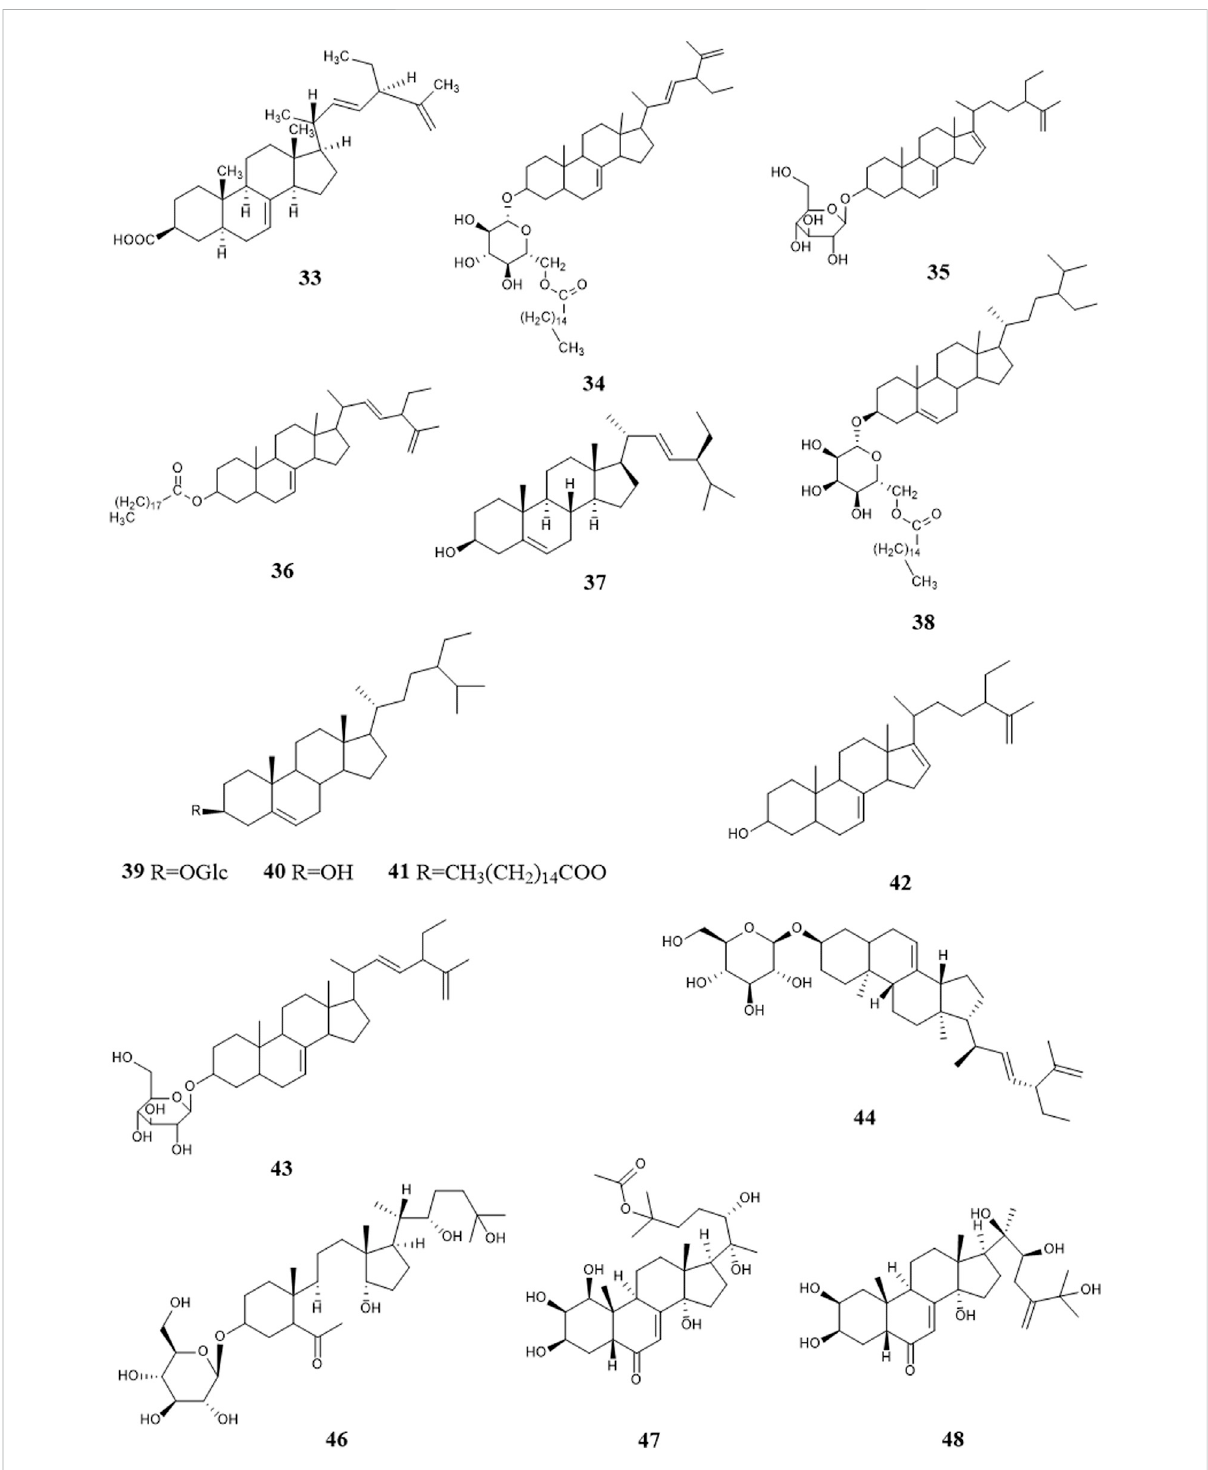
FIGURE 5 Structure of sterols from Bolbostemma paniculatum (Maxim.)